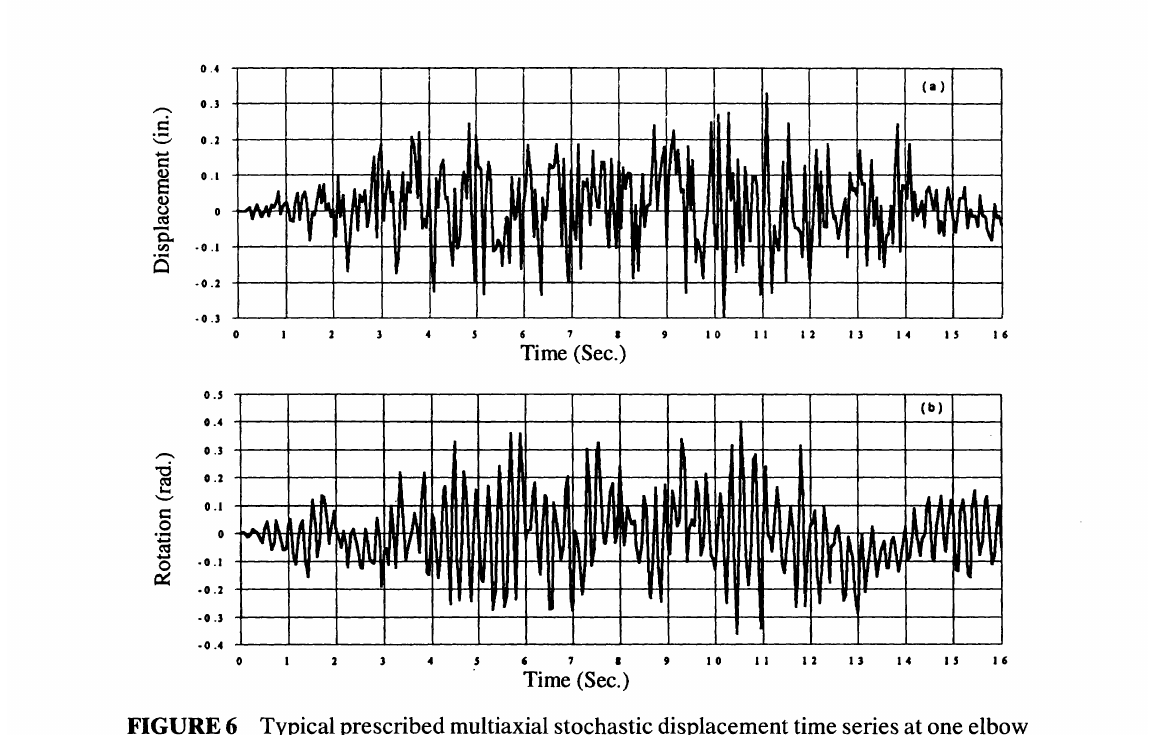
FIGURE 6 Typical prescribed multiaxial stochastic displacement time series at one elbow end with (a) translation in the x direction and (b) rotation in the xx